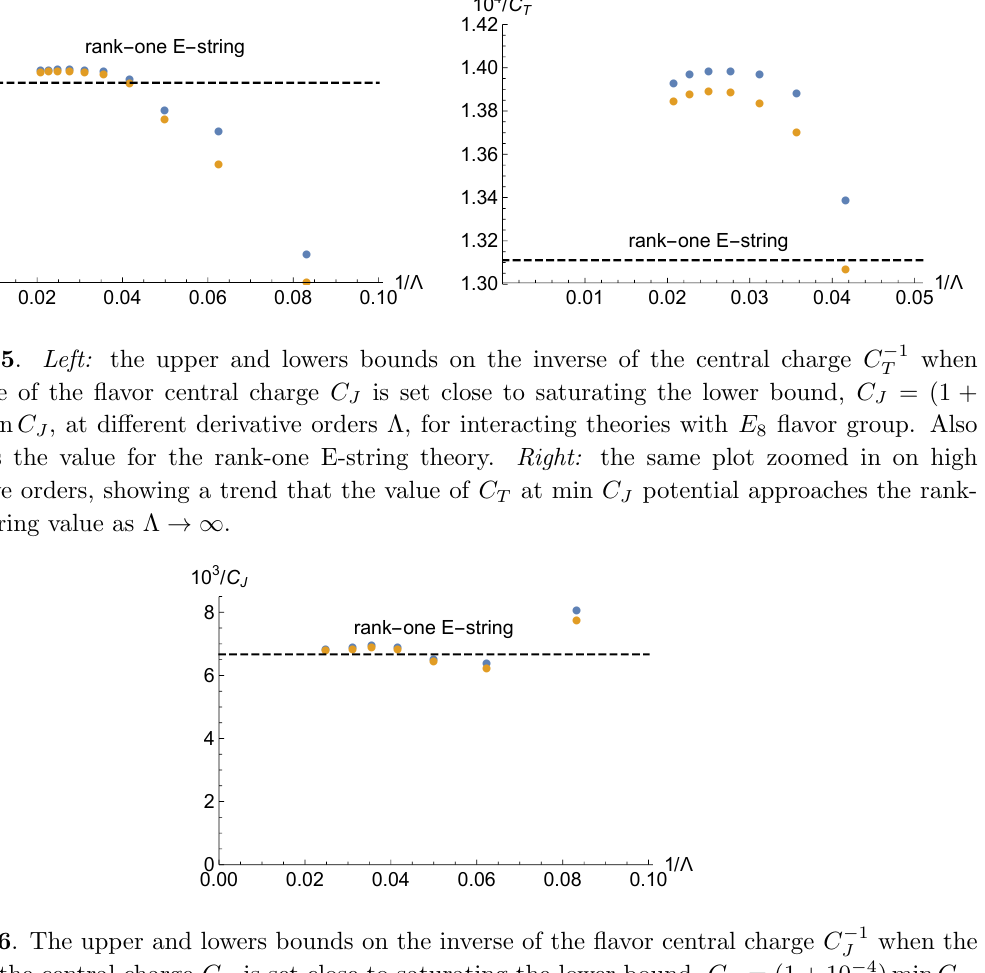
Figure 6 . The upper and lowers bounds on the inverse of the (cid:13)avor central charge C (cid:0) 1 value of the central charge C T is set close to saturating the lower bound, C T = (1 + 10 (cid:0) 4 ) min C T , at di(cid:11)erent derivative orders (cid:3), for interacting theories with E 8 (cid:13)avor group. Also shown is the value for the rank-one E-string